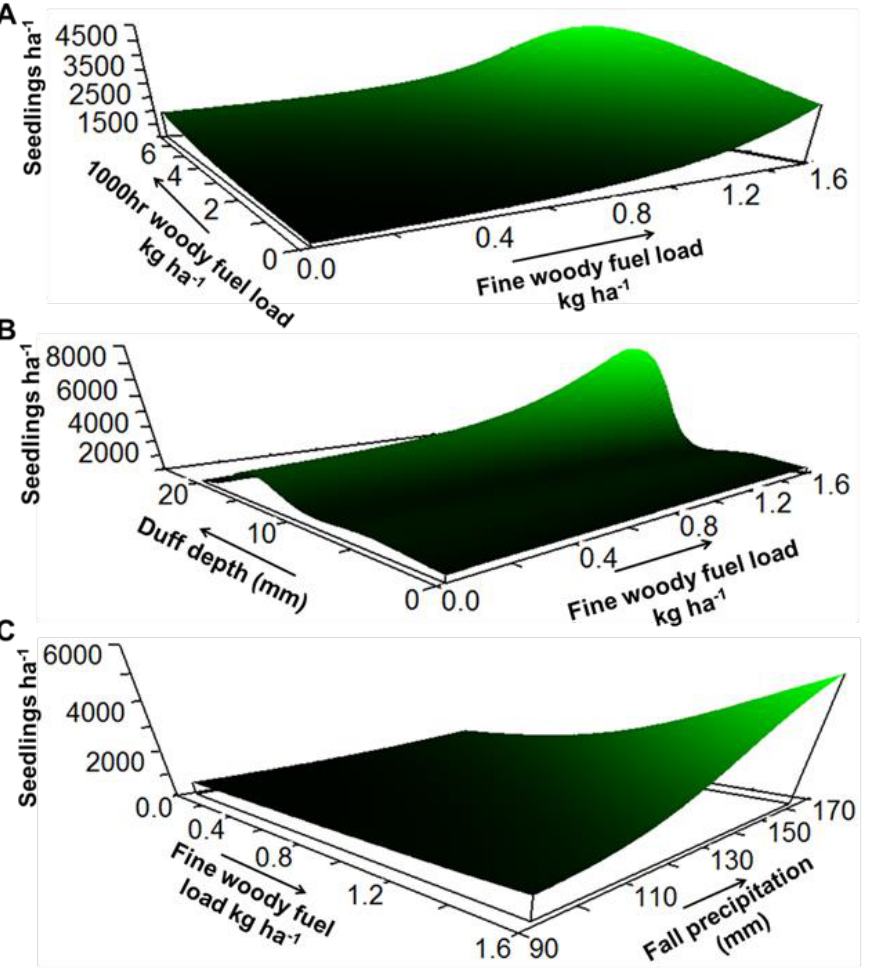
Figure 2. Ponderosa pine seedling density was impacted by fine woody fuel load, which interacted with ( A ) 1000 h woody fuel load, ( B ) duff depth, and ( C ) fall precipitation. Note that y -axis ranges and orientation of x -axis may vary among panels.